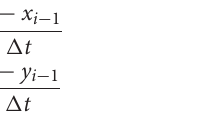
A forward kinematics calculation provides the displacement of the ankle in both axes, i.e., vertical and horizontal vs.